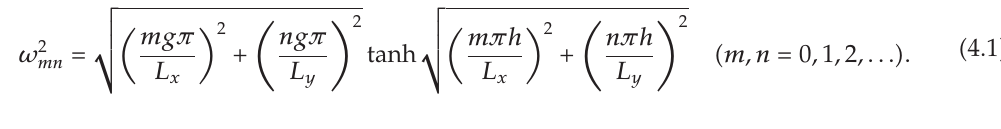
The tank dimension is L x (cid:9) L y (cid:9) 600 mm, and the water depth is h (cid:9) 300 mm, so that 50% of the tank is filled with water. The length and width of the tank was chosen to be equal to obtain the symmetric behavior of the cubic tank in this study. So, the lowest natural frequency is ω 10 (cid:9) ω 01 (cid:9) 6 . 8636 rad/s due to the symmetry of the cubic tank. The computational domain is discretized by 120 × 60 uniform meshes with the mesh size Δ x (cid:9) 5 mm and Δ y (cid:9) 10 mm in the horizontal plane and 100 nonuniform vertical meshes with 20 meshes being arranged near the free surface, where the minimum mesh size is Δ z (cid:9) 3 mm. The horizontal excitation velocity of the tank follows cosine function, that is, u (cid:9) − A cos ωt for t ≥ 0, where A (cid:9) aω is the velocity amplitude with a (cid:9) 5 mm being the displacement amplitude and ω is the angular frequency of the excitation. In the following simulations, the excitation frequency ω would be chosen as π and 6.8636 rad/s,